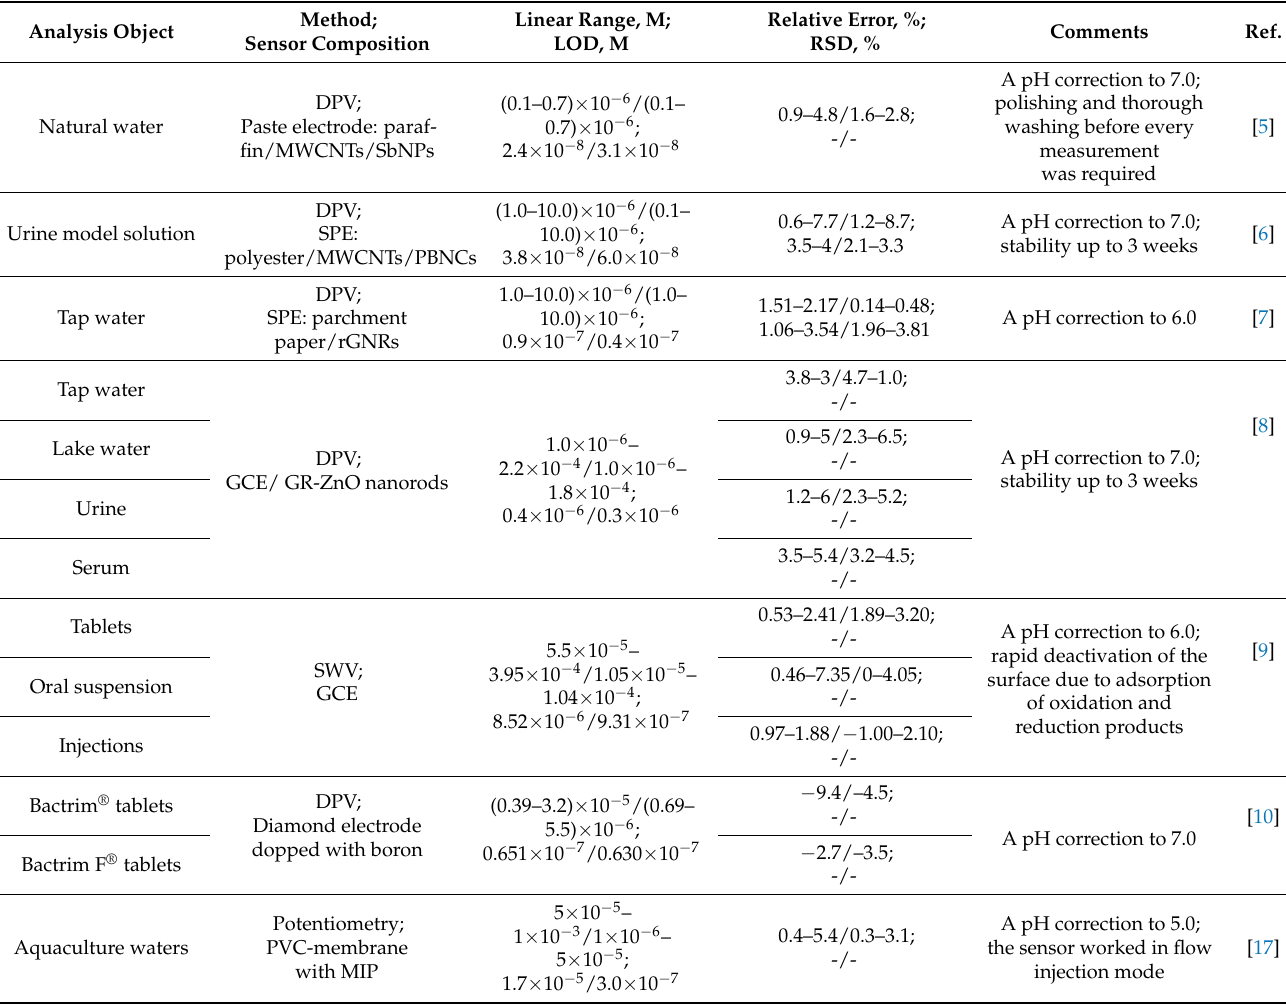
Table 1. The characteristics of electrochemical sensors for the simultaneous determination of SMX and TMP (the numerator is for SMX, and the denominator is for